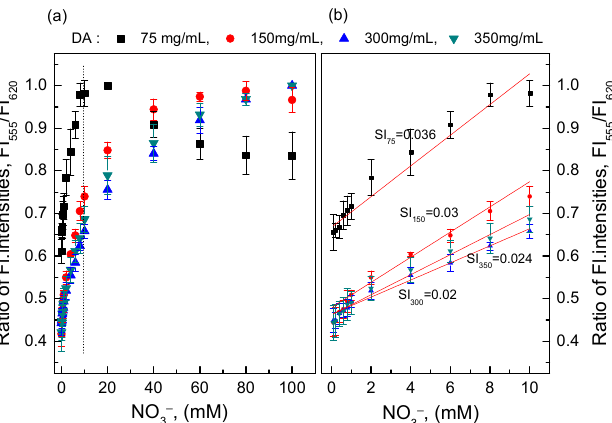
Figure 1. ( a ) The response of the oxazine170 perchlorate–ethyl cellulose (O17-EC) membrane to the ammonia produced from the reductive reaction of different nitrate concentrations with different amounts of Devarda’s alloy (DA); ( b ) Slope (SI) from linear calibration curves of the O17-EC membrane in the nitrate concentration range of 0.1–10 mM.